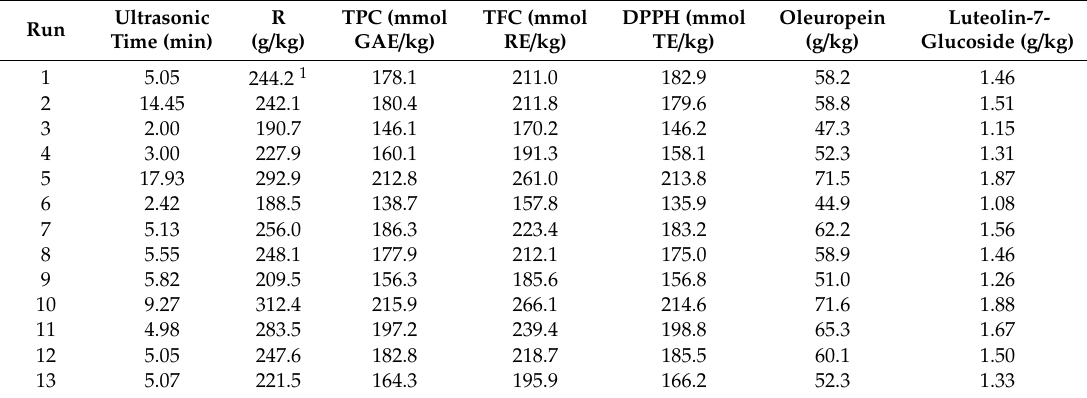
Table 2. Responses for the central composite design obtained of the extractions by UAE 1